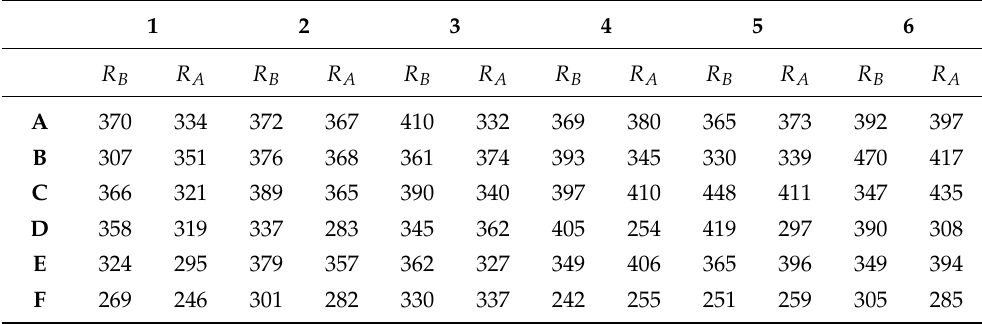
Table 1. Electrical soil resistance values under controlled conditions for soil water content mapping.